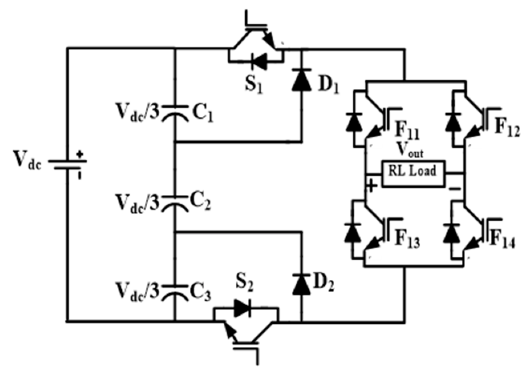
Figure 1. Proposed basic unit.